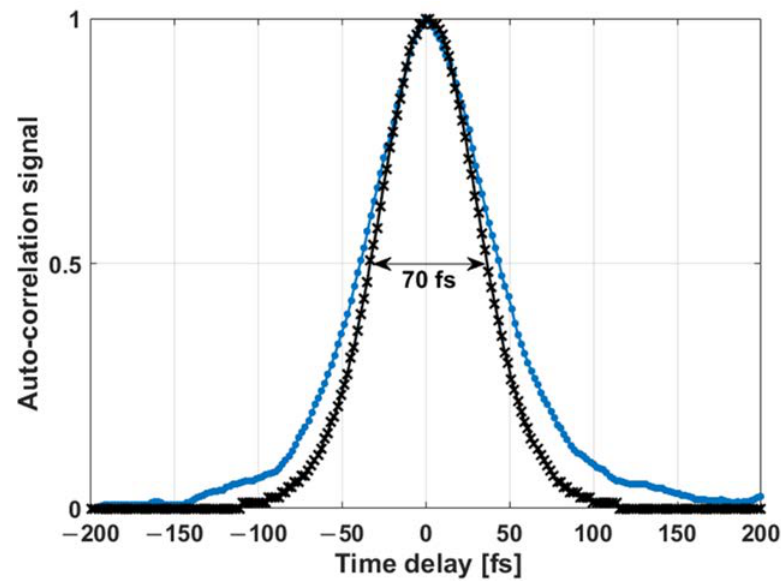
Figure 8. Autocorrelation trace at the output of the endoscopic double clad fiber (DCF) fiber (black curve) and at the output of the MEMS scanning system (blue curve).